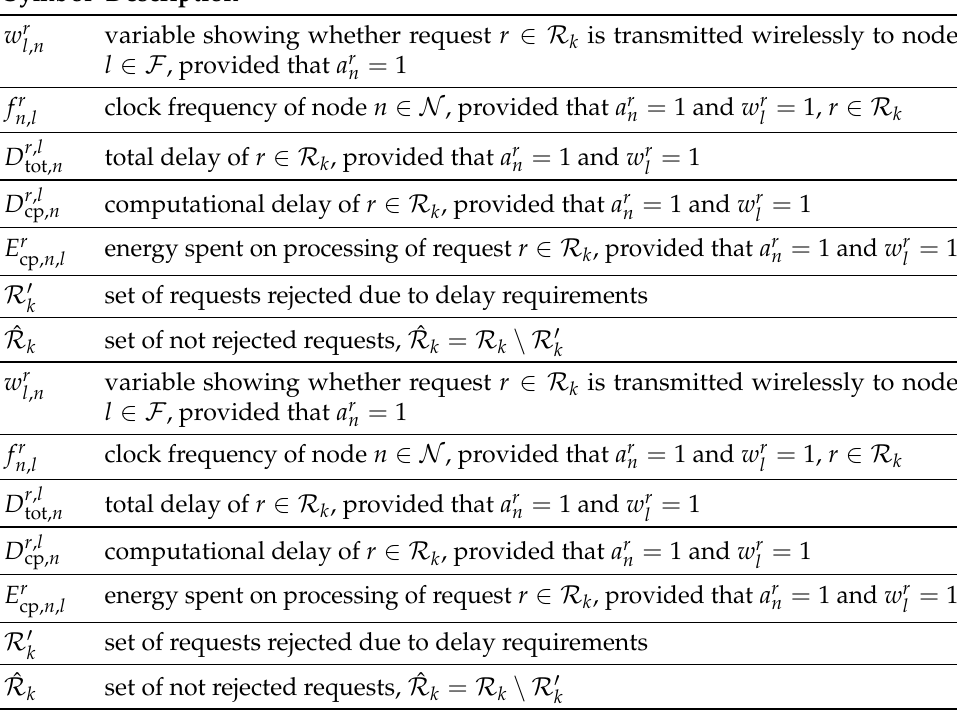
Table 3. Additional notation used in the problem